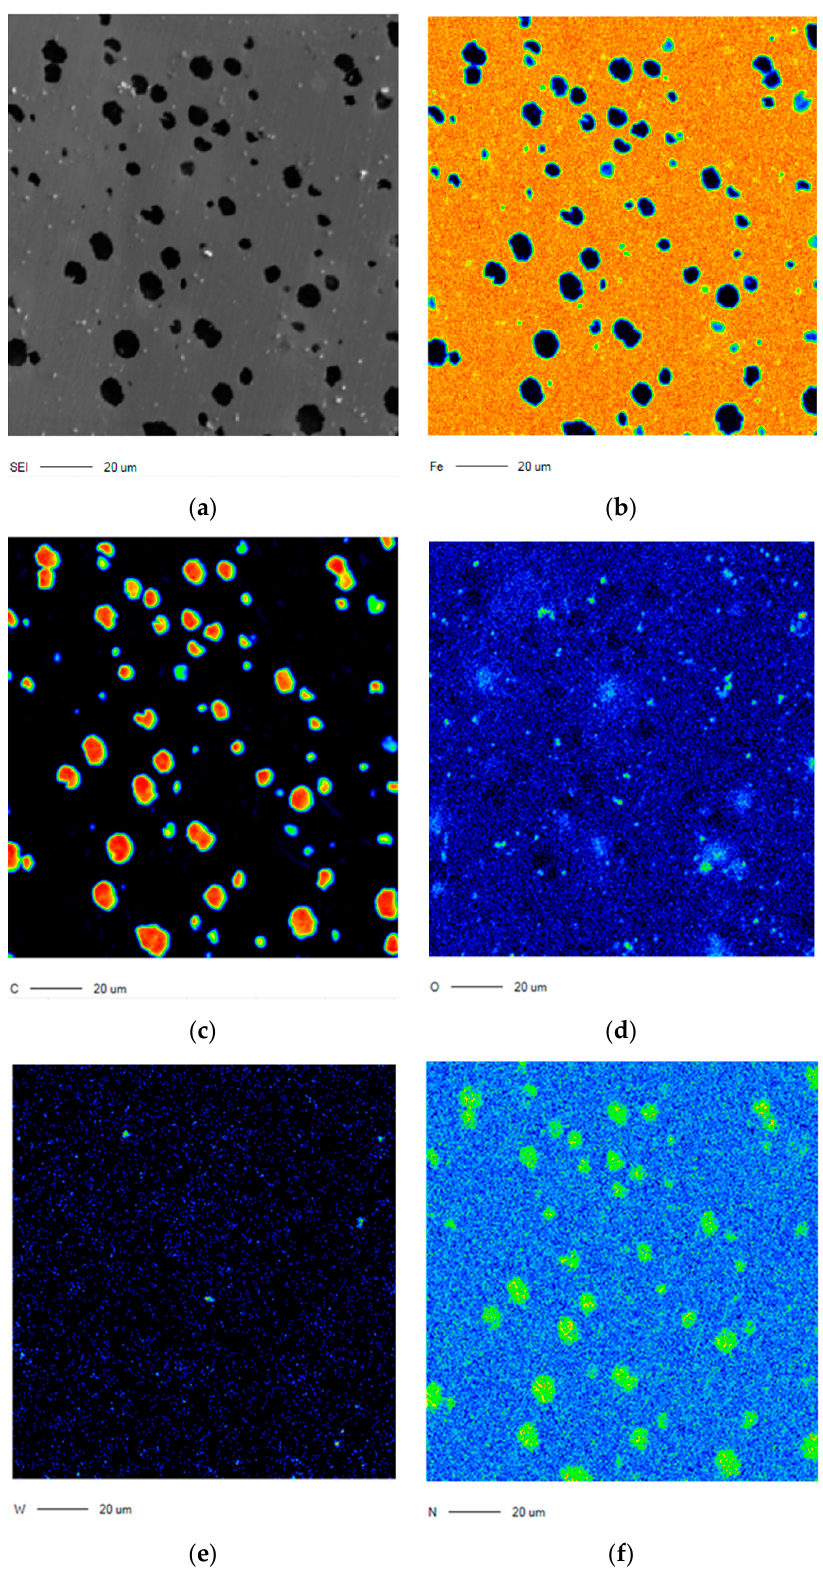
Figure 11. Elemental distribution analyzed by EPMA on the surface of DCI passivated for 72 h in tap water with 1 k ppm tungstate + 1 k ppm MEA at room temperature. ( a ) SEM image, ( b ) Fe, ( c ) C, ( d ) O, ( e ) W, ( f ) N.